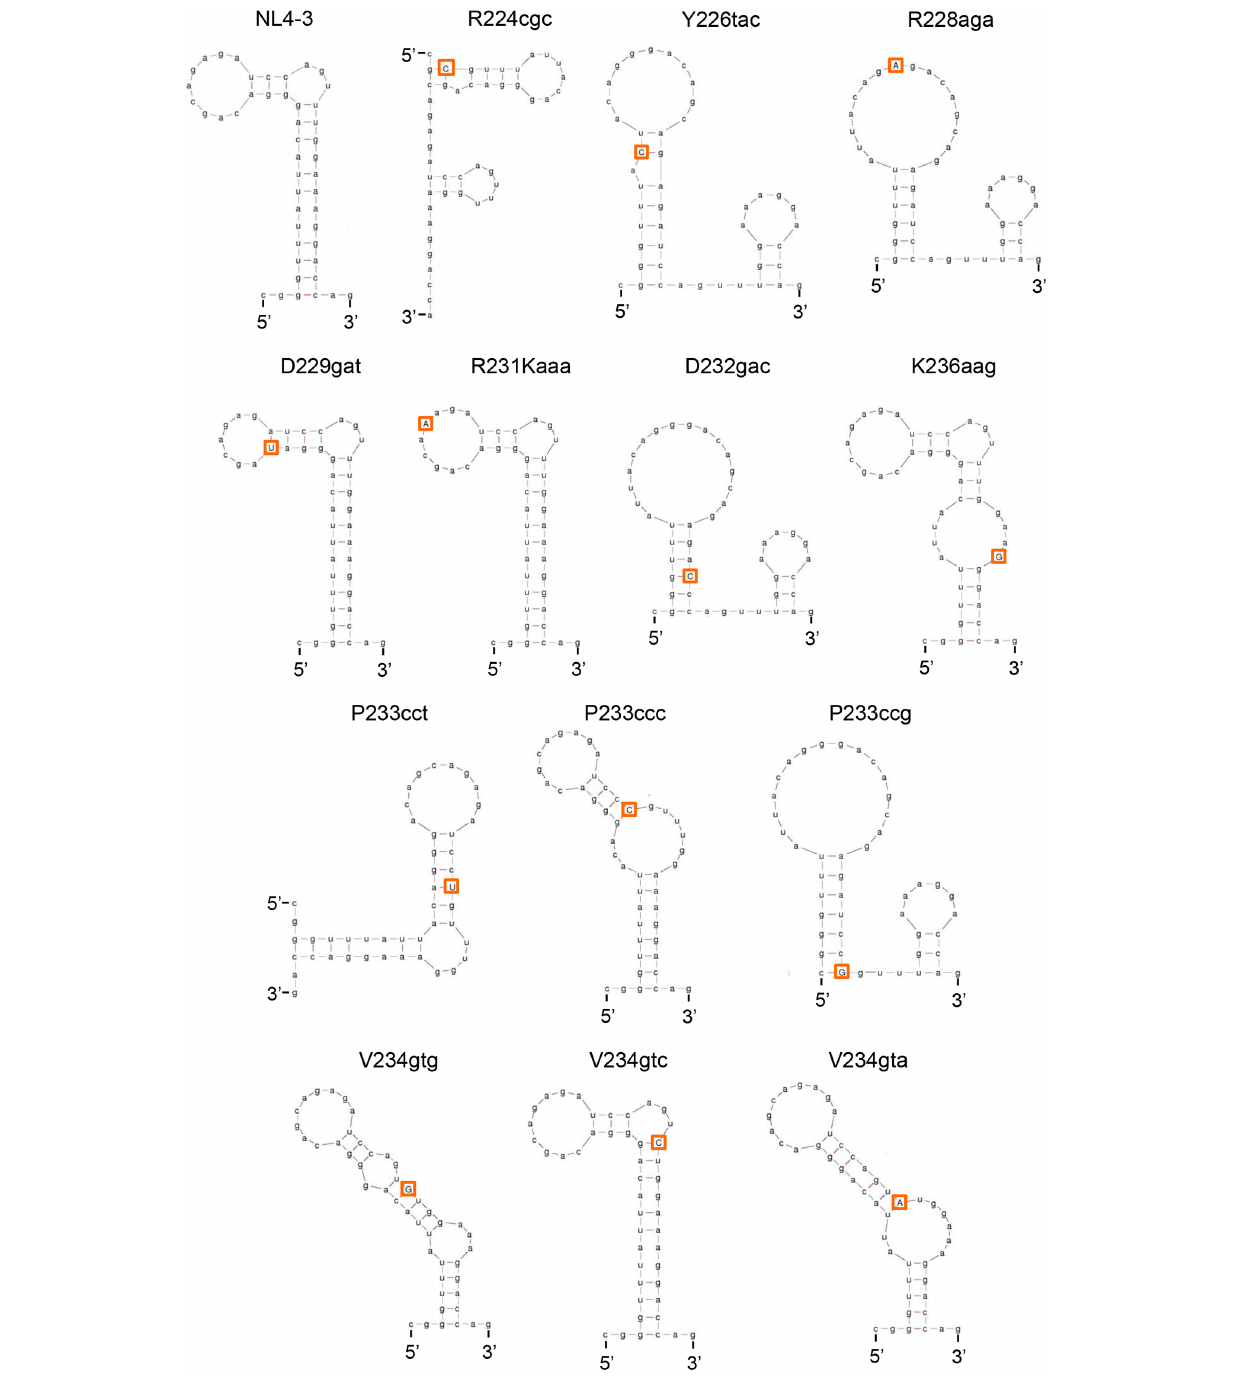
of a G-C canonical pair instead of a G · U wobble pair ( d G is − 7.7 for V234gtc and − 5.7 for NL4-3) ( Figure 7 ). Moreover, V234gtc produced higher level of vif mRNA relative to NL4-3 ( ∼ 1.5) ( Figure 7 ). While only R231Kaaa gave the same